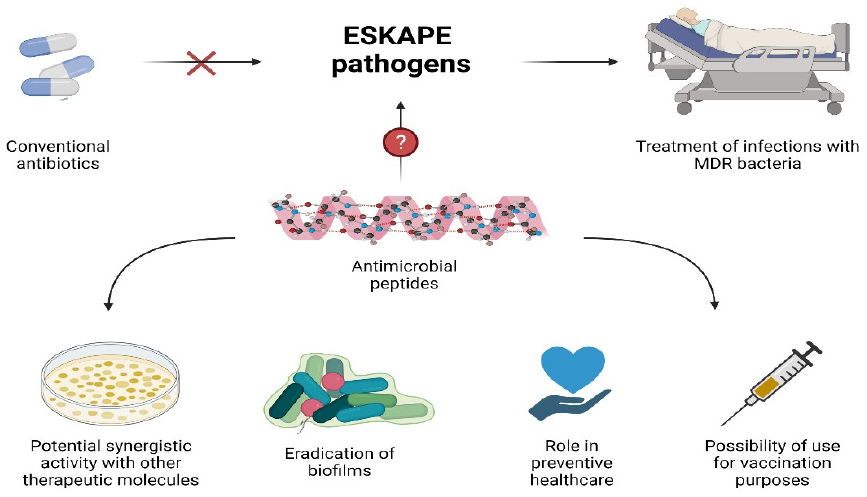
Figure 3 . Potential use of AMPs